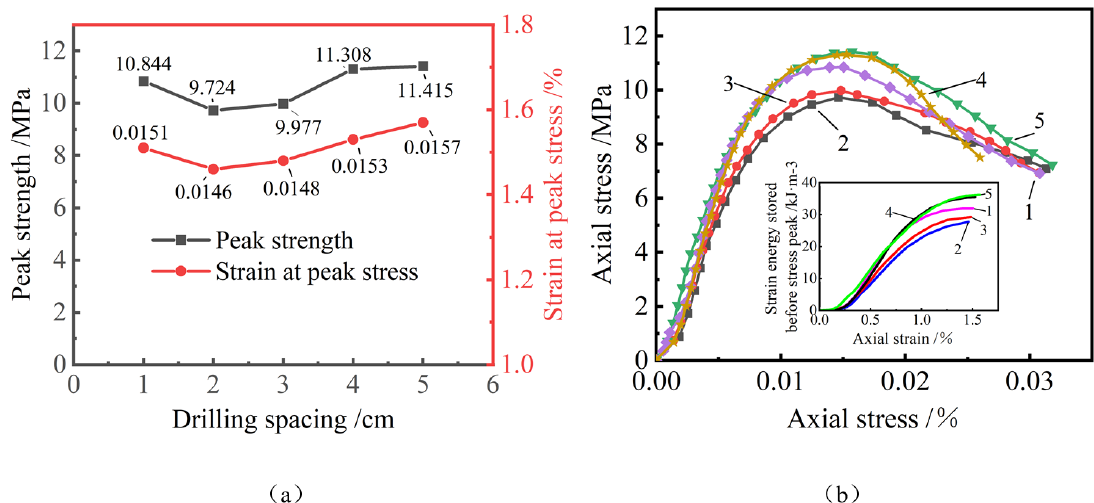
Figure 4. ( a ) is the peak strength of the test block under different hole spacing, and ( b ) is the stress– strain curve. stress–strain